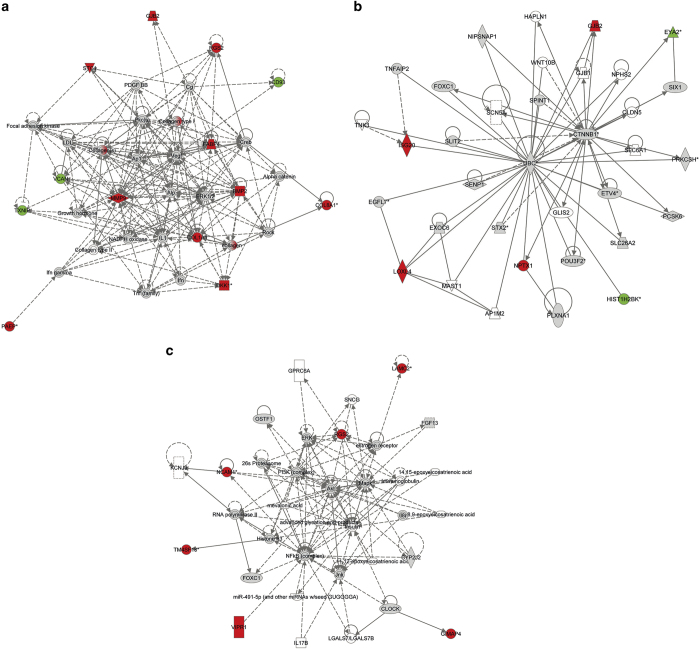
Figure 3. Network analysis based on differentially expressed genes between 143BNSC and 143BGBM tumours in (a) cancer, cardiovascular system development and function, and organismal development, (b) cancer, gastrointestinal disease and hepatic system disease, and (c) cell cycle, cardiovascular system development and function networks (red – upregulated in 143BNSC; green – downregulated in 143BNSC, fold change>2, P<0.05).